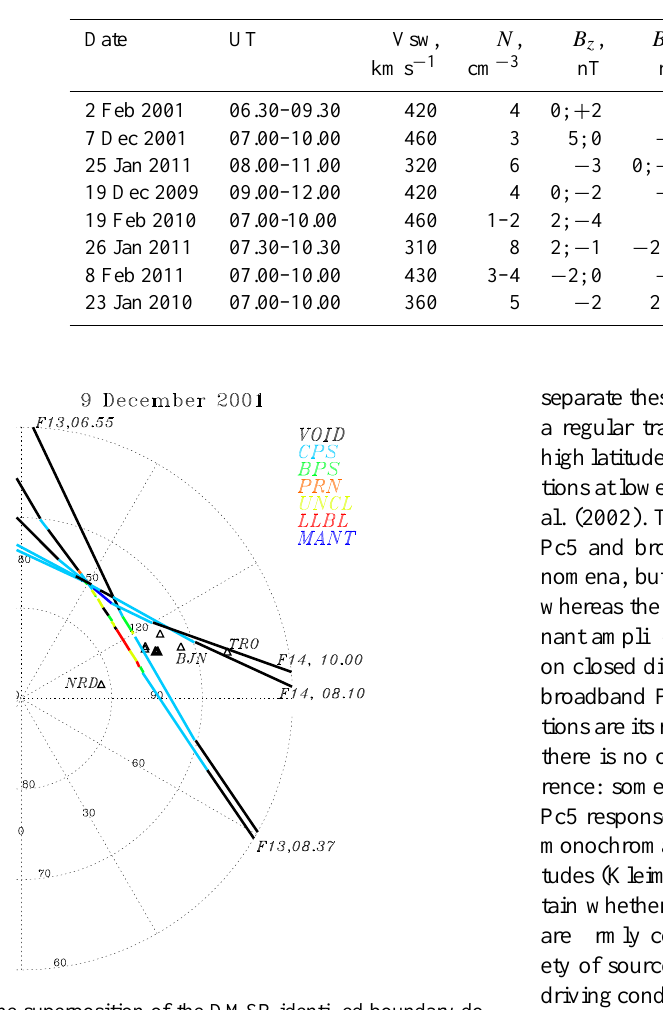
Table 2. Interplanetary parameters and cusp location during selected events.